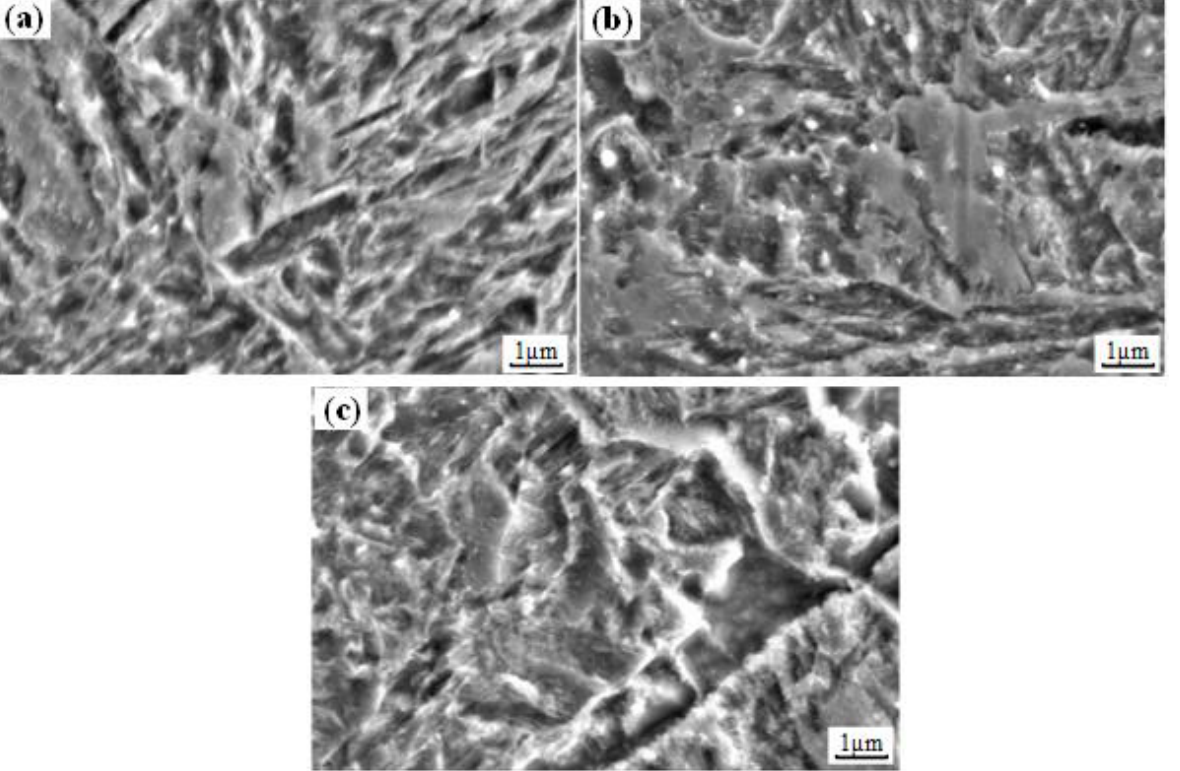
Figure 8. Metallographic structures of machined sample: ( a ) overall view and ( b ) local enlarged view.